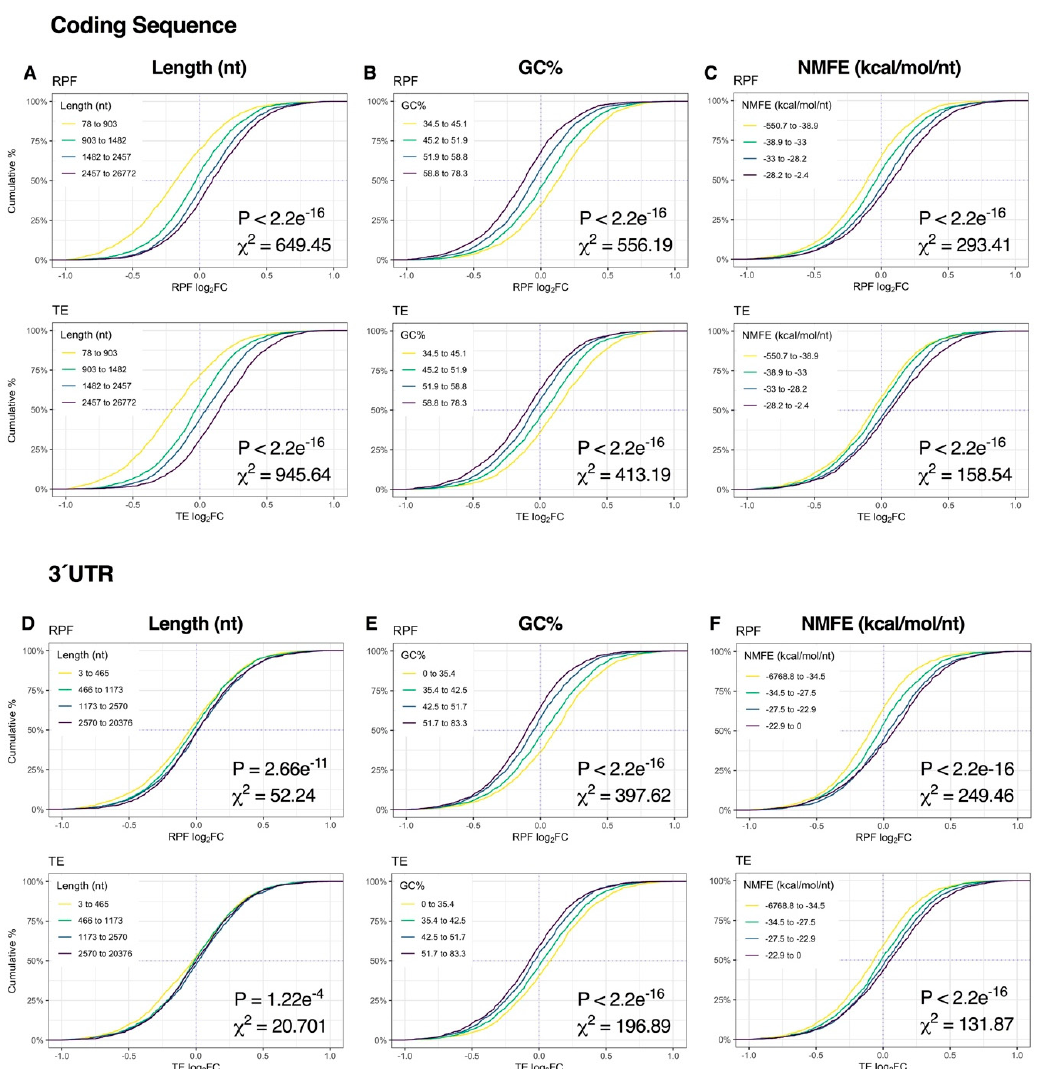
Figure 5. Relationship between mRNA dynamics and sequence features 2 h after depolarization. ( A–C ) Cumulative density plots depicting changes in RPF and TE log 2 FC after binning genes into quartiles by coding sequence length ( A ), GC% ( B ) or minimum free energy of secondary structures normalized to sequence length (NMFE) ( C ). All groups were compared via Kruskal–Wallis test, with associated p -values and Chi-squared ( χ 2 ) test statistics reported (bottom right). ( D – F ) As in ( A – C ), except examining the same features in the 3´UTR. See Supplementary Figure S7 for the full version with RPF data, Supplementary Figure S6 for 5´UTR data and Supplementary Figure S9 for G4, uAUG and RCF data. ChangesinmRNAdynamicsassociatedwithG4structureswerecomparativelymodest.